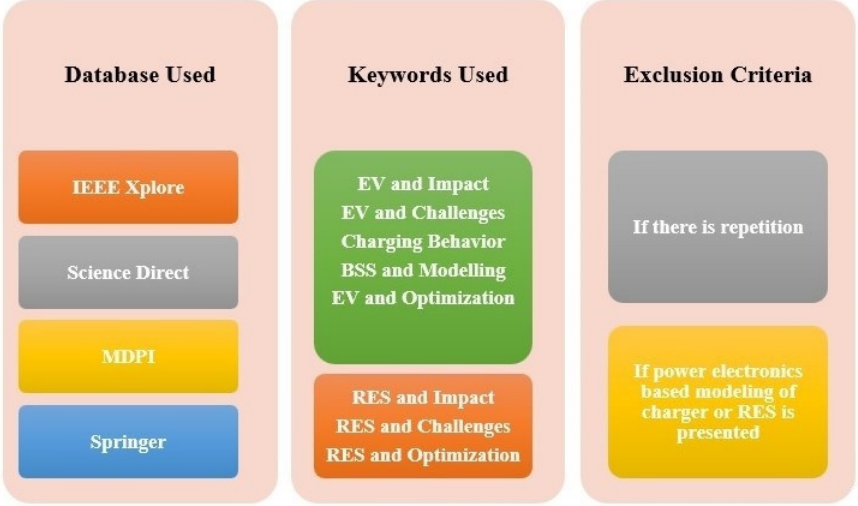
Figure 1. Search Criteria followed in the